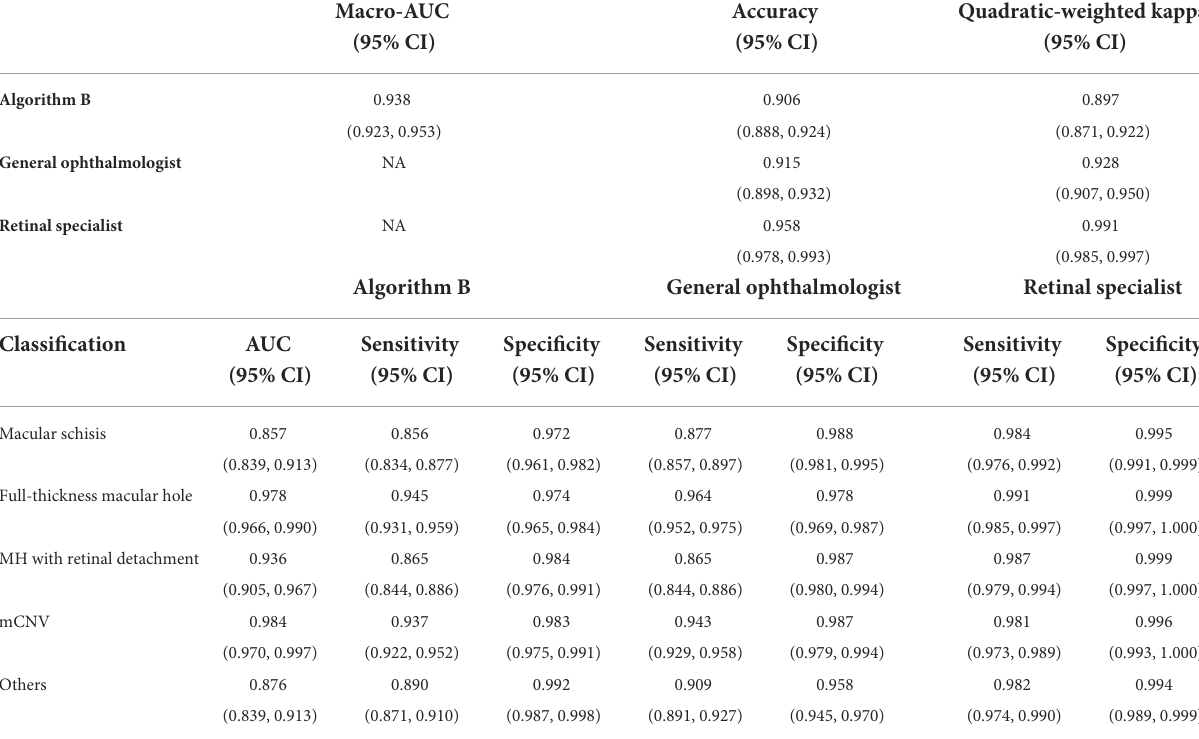
TABLE 3 Comparison of the performance of the algorithm B and experts in external validation dataset.